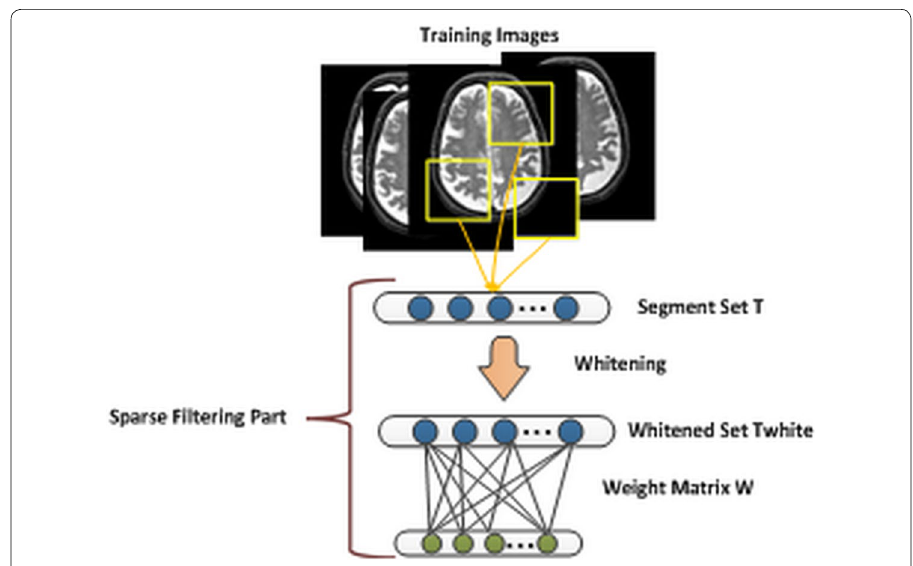
Fig. 3 Sparse filtering training